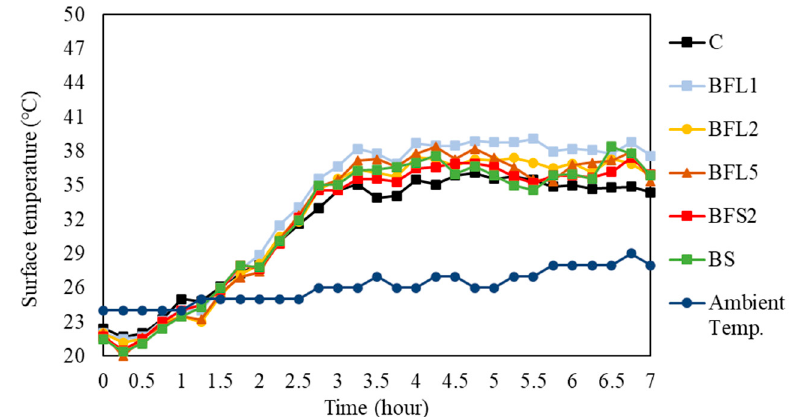
Figure 8. Surface temperature of the interlocking blocks (surface layer).